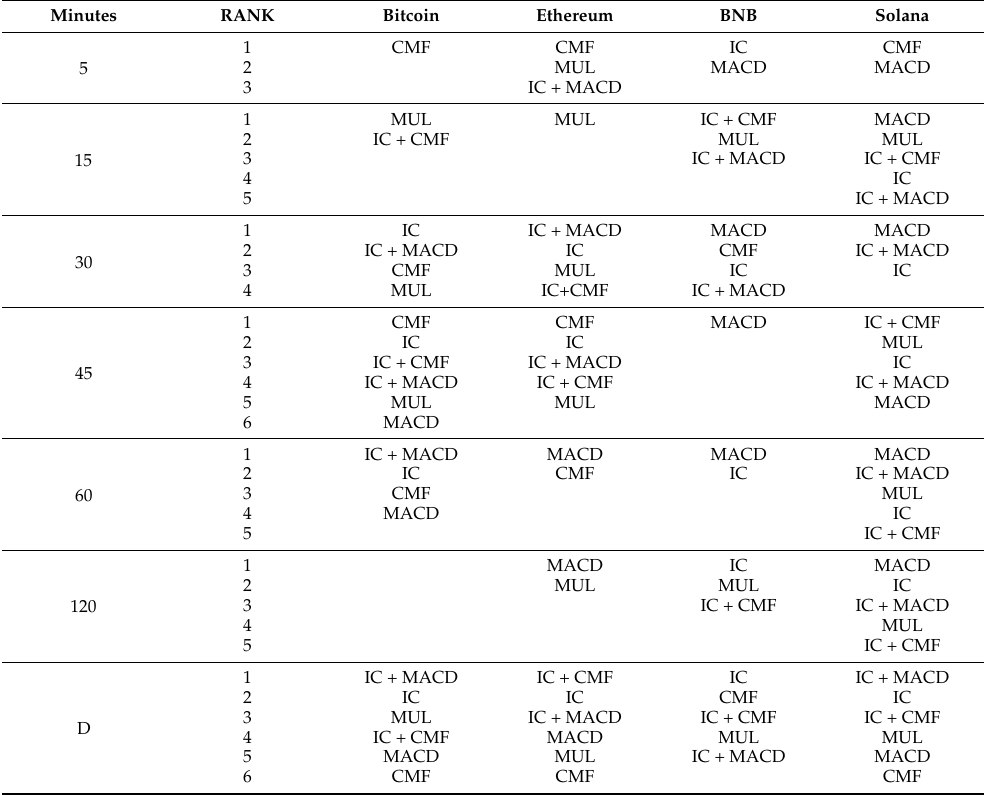
Table 7. Summarizing